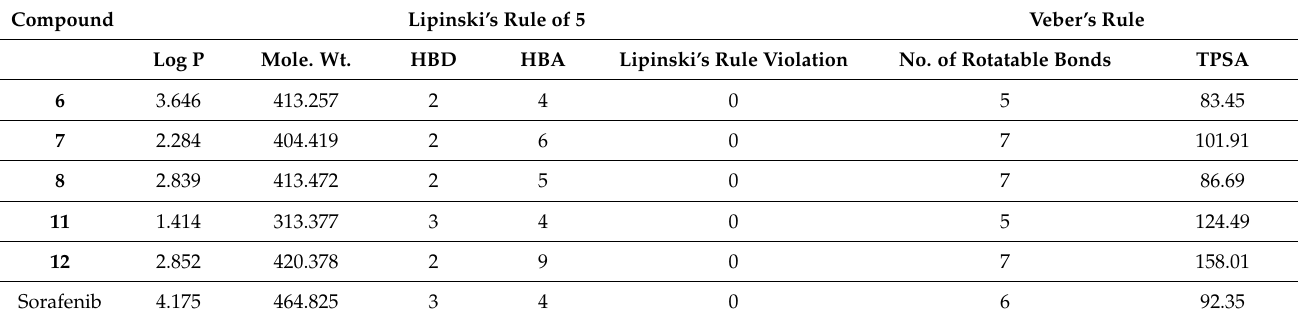
Table 9. Lipinski’s rule of five and Veber’s rule for the synthesized compounds and